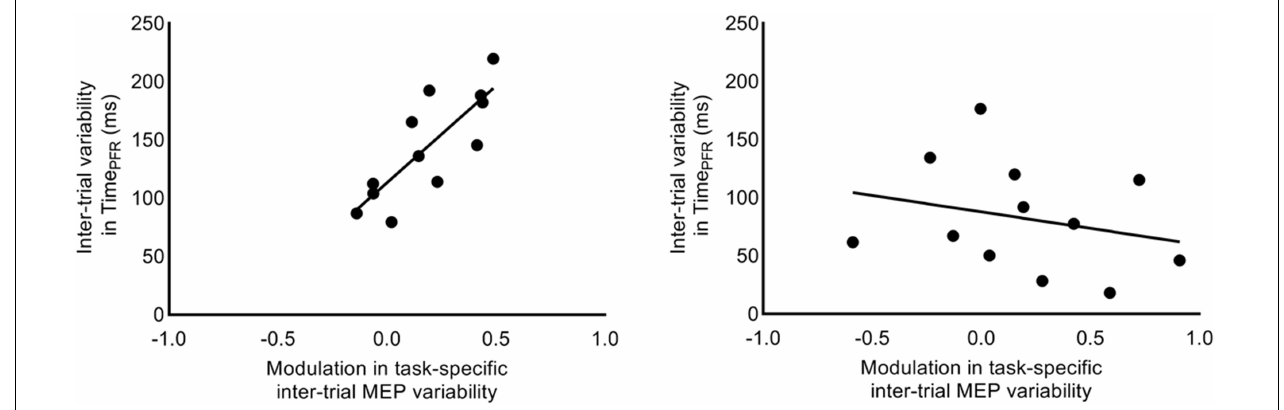
FIGURE 8 | Correlation between intertrial task-specific variability in MEP and time to peak force rate. Modulation in intertrial MEP variability (CV DIFF of MEP) for FDI muscle explained inter-individual differences in trial-to-trial fluctuations in time to peak force rate, selectively at 30% ( r = 0.80, p = 0.0017), but not at 5% ( r = –0.25, p = 0.4228) of